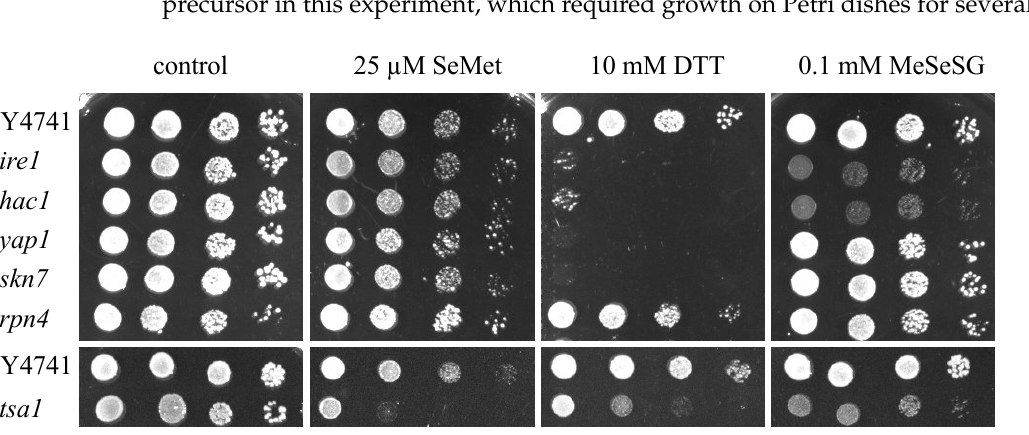
Figure 4. Sensitivity of yeast null-allele strains to SeMet, MeSeSG and DTT. Ten-fold serial dilutions of the indicated strains were spotted on solid SC + 100 µM methionine plates containing no toxic (control), SeMet (25 µM), DTT (10 mM) or MeSeSG (100 µM) and grown 48 h at 30 °C.